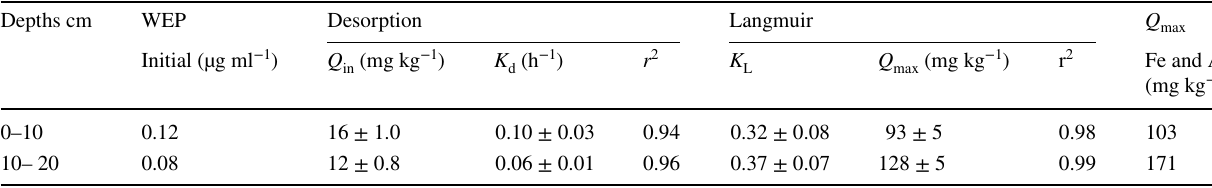
Table 8 Values of adsorbed P estimated by the Langmuir equation from the P content in equilibrium with water at the depths 0–10 and 10–20 cm of a Dystric Xeropsamments treated with organic and inorganic sources after leaching with 10 PV